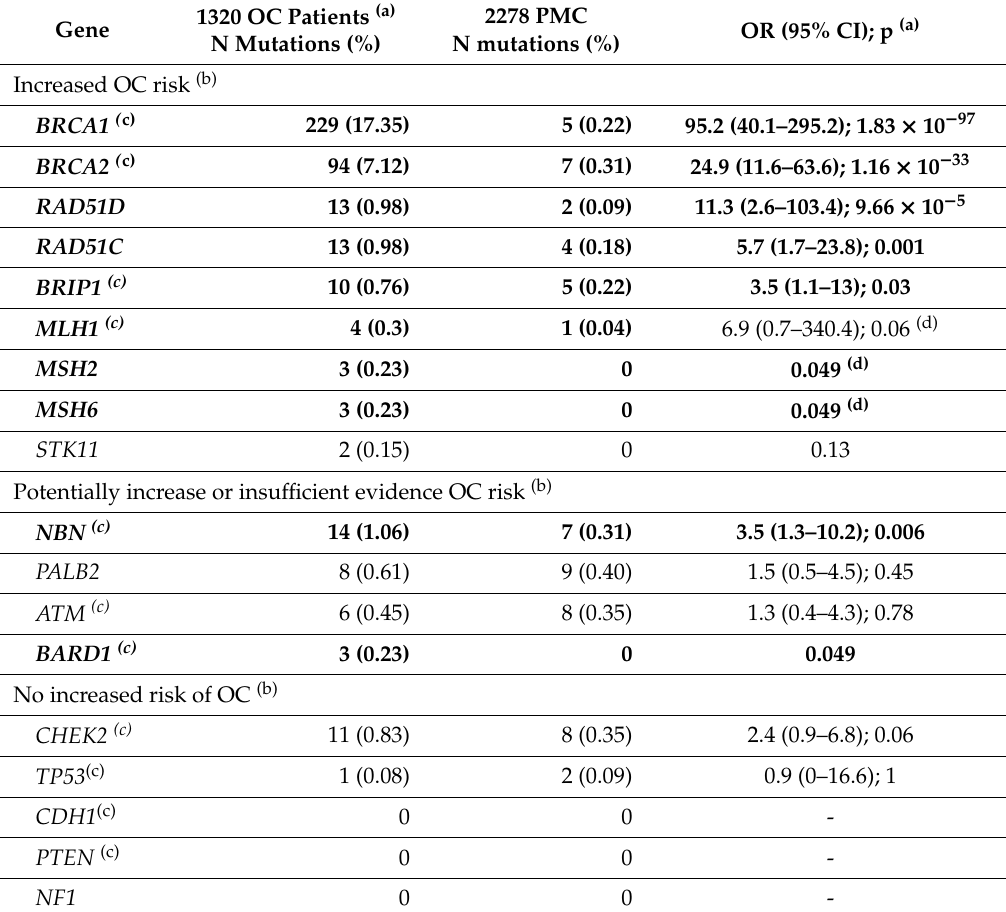
Table 1. Mutation frequencies in 1320 ovarian cancer cases and in 2278 population-matched controls